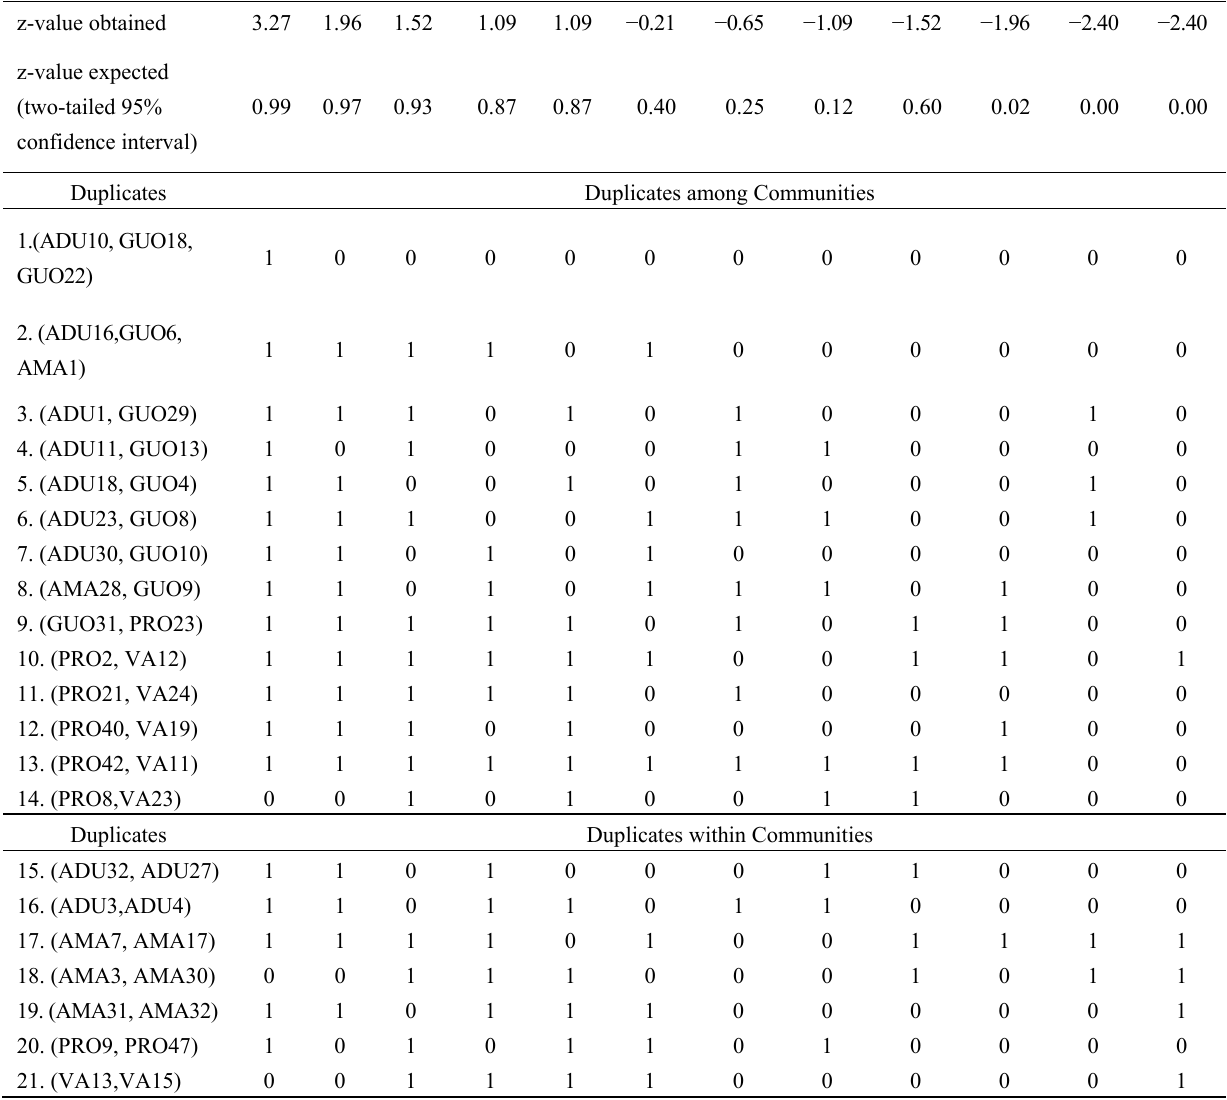
Table 2. Comparison of genotypic duplicates indicating which morphological variables indigenous farmers considered equal (value = 1), and which morphological variables they considered different (value = 0) between samples. A Z-test was used to establish the differences among variables discriminating between duplicates. Variables: 1. Class of manioc; 2. Color of bulking root pulp; 3. Uses; 4. Soil in which the landrace grows better; 5. Preferred character to maintain the landrace; 6. Color of petiole; 7. Color of mature leaf; 8. Plant branching; 9. Color of apical leaf; 10. Color of bulking root cortex; 11. Shape of leaf